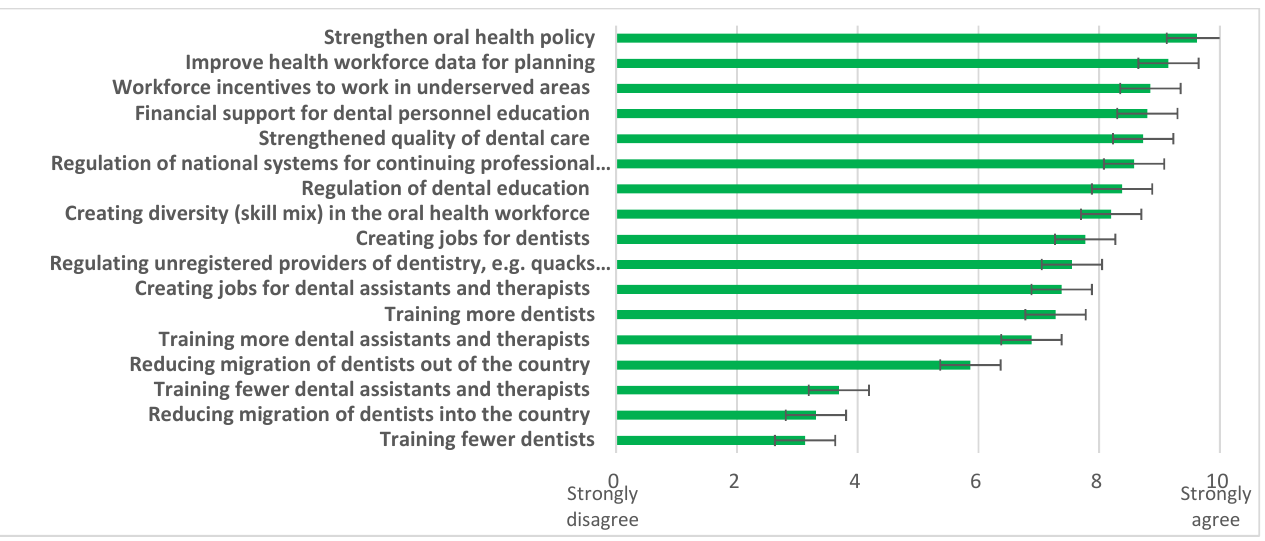
Figure 5. Possible solutions related to the OHWF highlighted by the AFR, 2019. Source: King’s College London & WHO Survey, 2019.